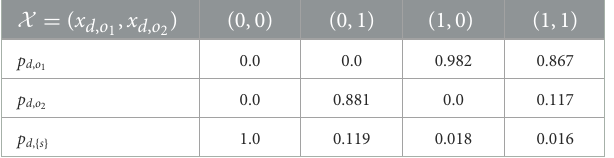
, x d , o ) values 1 2